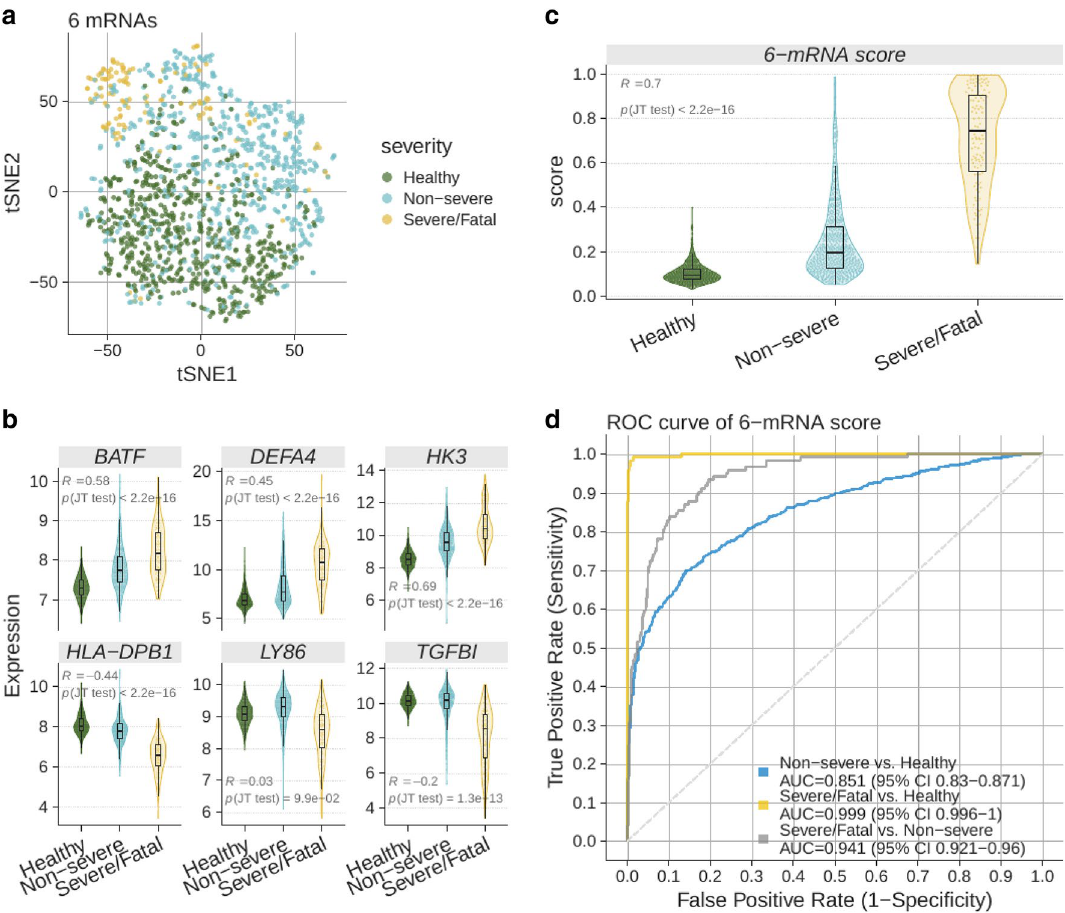
Figure 3. Validation of the 6-mRNA classifier in the independent retrospective non-COVID-19 cohorts. ( a ) Visualization of the samples using t-SNE. ( b ) Expression of the 6 genes used in the logistic regression model in patients with clinically relevant subgroups. ( c ) 6-mRNA classifier accurately distinguishes non-severe and severe patients with COVID-19 as well as those who died. ( d ) ROC plot for the subgroups. Excluding healthy samples, about 65% of the blood samples were estimated to have been collected “early”, and 35% “late”. See “Standardized severity assignment for retrospective non-COVID-19 patient samples” for details. Variable